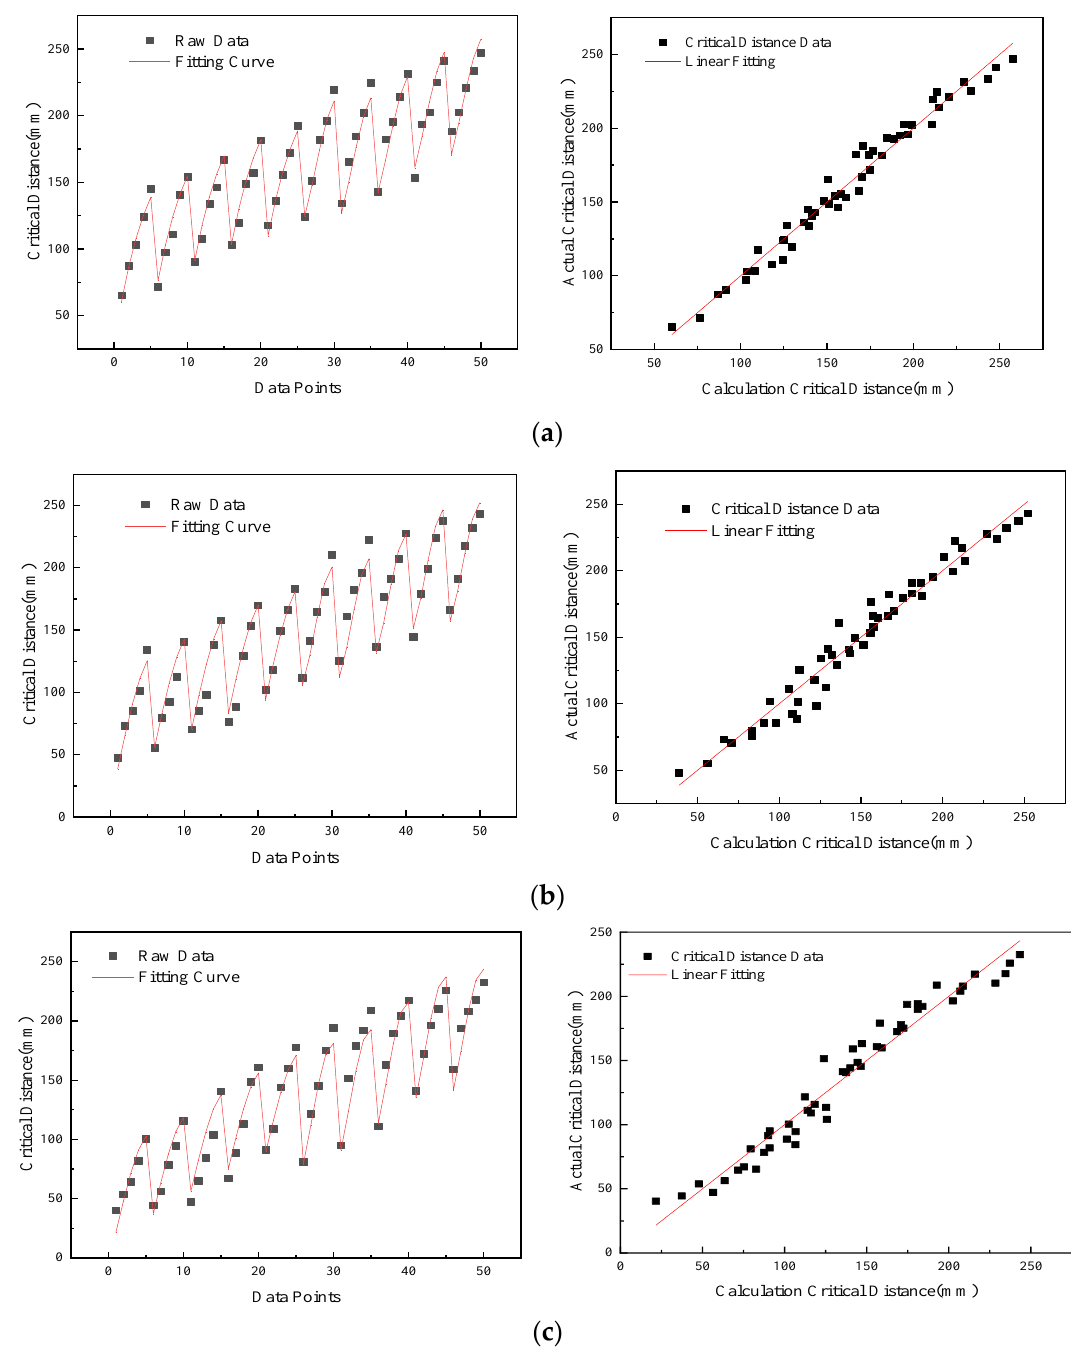
Figure 7. Critical distance regression fitting curve of different pipe models: ( a ) the exterior wall; ( b ) the interior wall; ( c ) the interior and exterior wall.